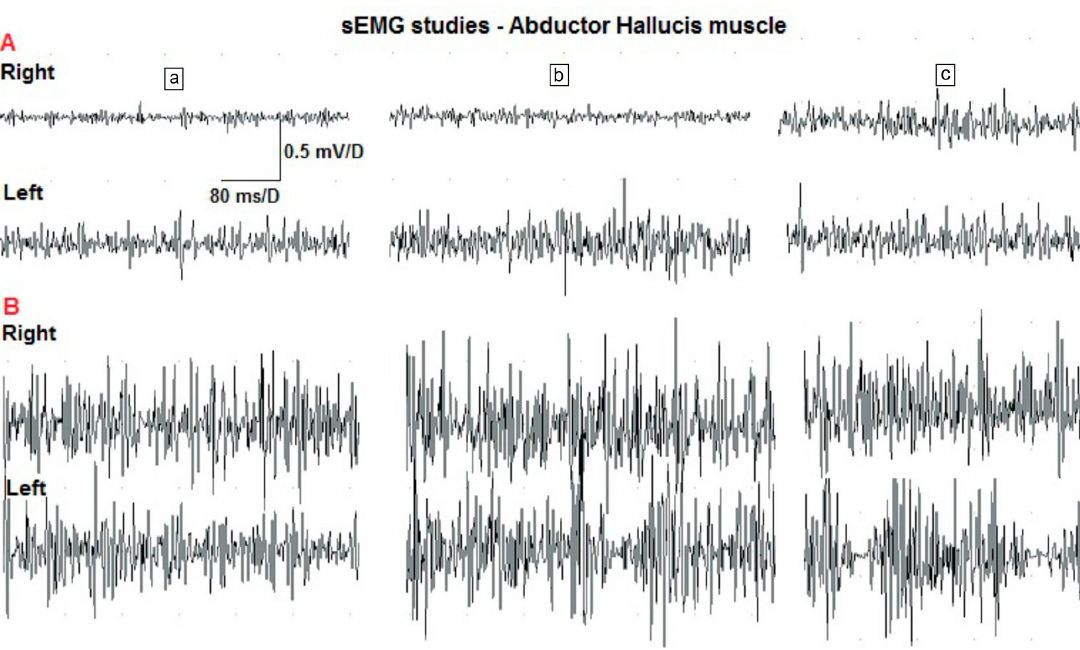
Figure 4. Sample sEMG results of a selected patient from study group A (a—the first phase of TSO exercises, b—the second phase of TSO exercise, c—the third phase of TSO exercise, right—recording from AbdH in the right foot, left—recording from AbdH in the left foot).